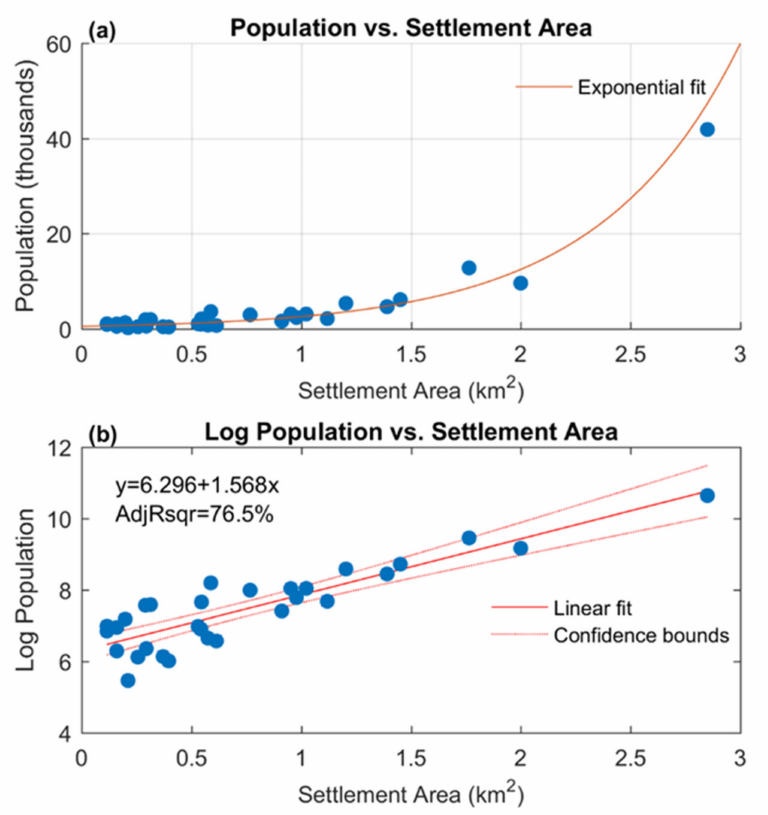
Figure 7. An exponential trend is identified between Population (as derived from Census data) and Settlement area (as derived from the Corona image) ( a ) and Linear regression of Log Population vs. Settlement area ( b ) reveals a statistically significant linear relationship with a good fit (adjusted R 2 = 76.5, p -values < 0.001 for F-test (significance) and t-test (coefficients), confidence level of the bounds is